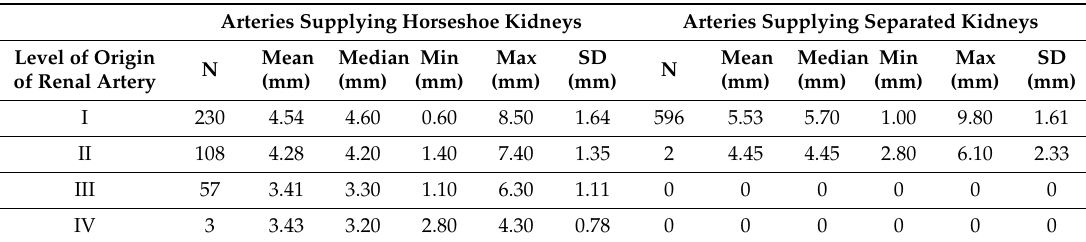
Table 2. The diameters of renal arteries according to branching level. Arteries Supplying Horseshoe Kidneys